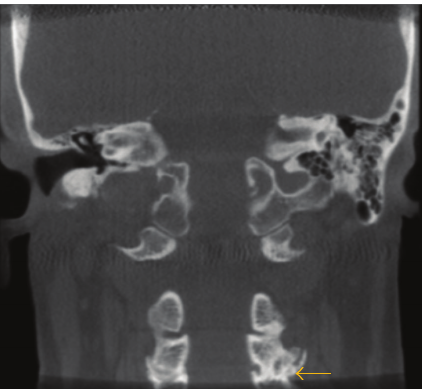
Figure 9: Carotid artery calcifications are seen bilaterally on this axial